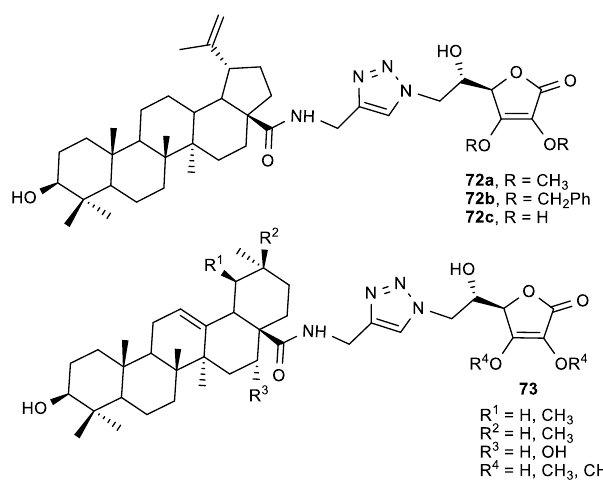
Figure 27. The pentacyclic triterpene ASA conjugates.